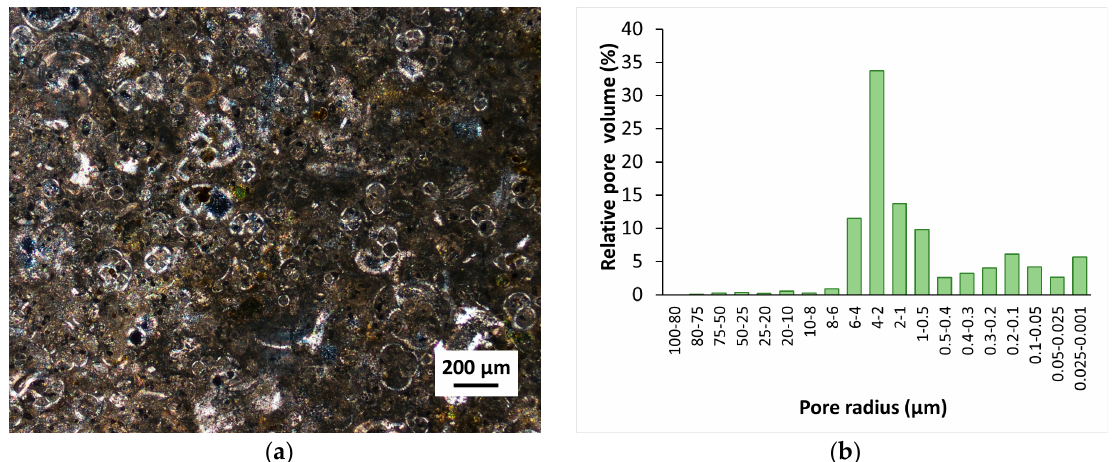
Figure 1. Lecce stone: ( a ) image taken on thin sections through optical microscope (Eclipse LV 100 PL, Nikon, Tokyo, Japan) in transmitted light; ( b ) pore-size distribution curve.